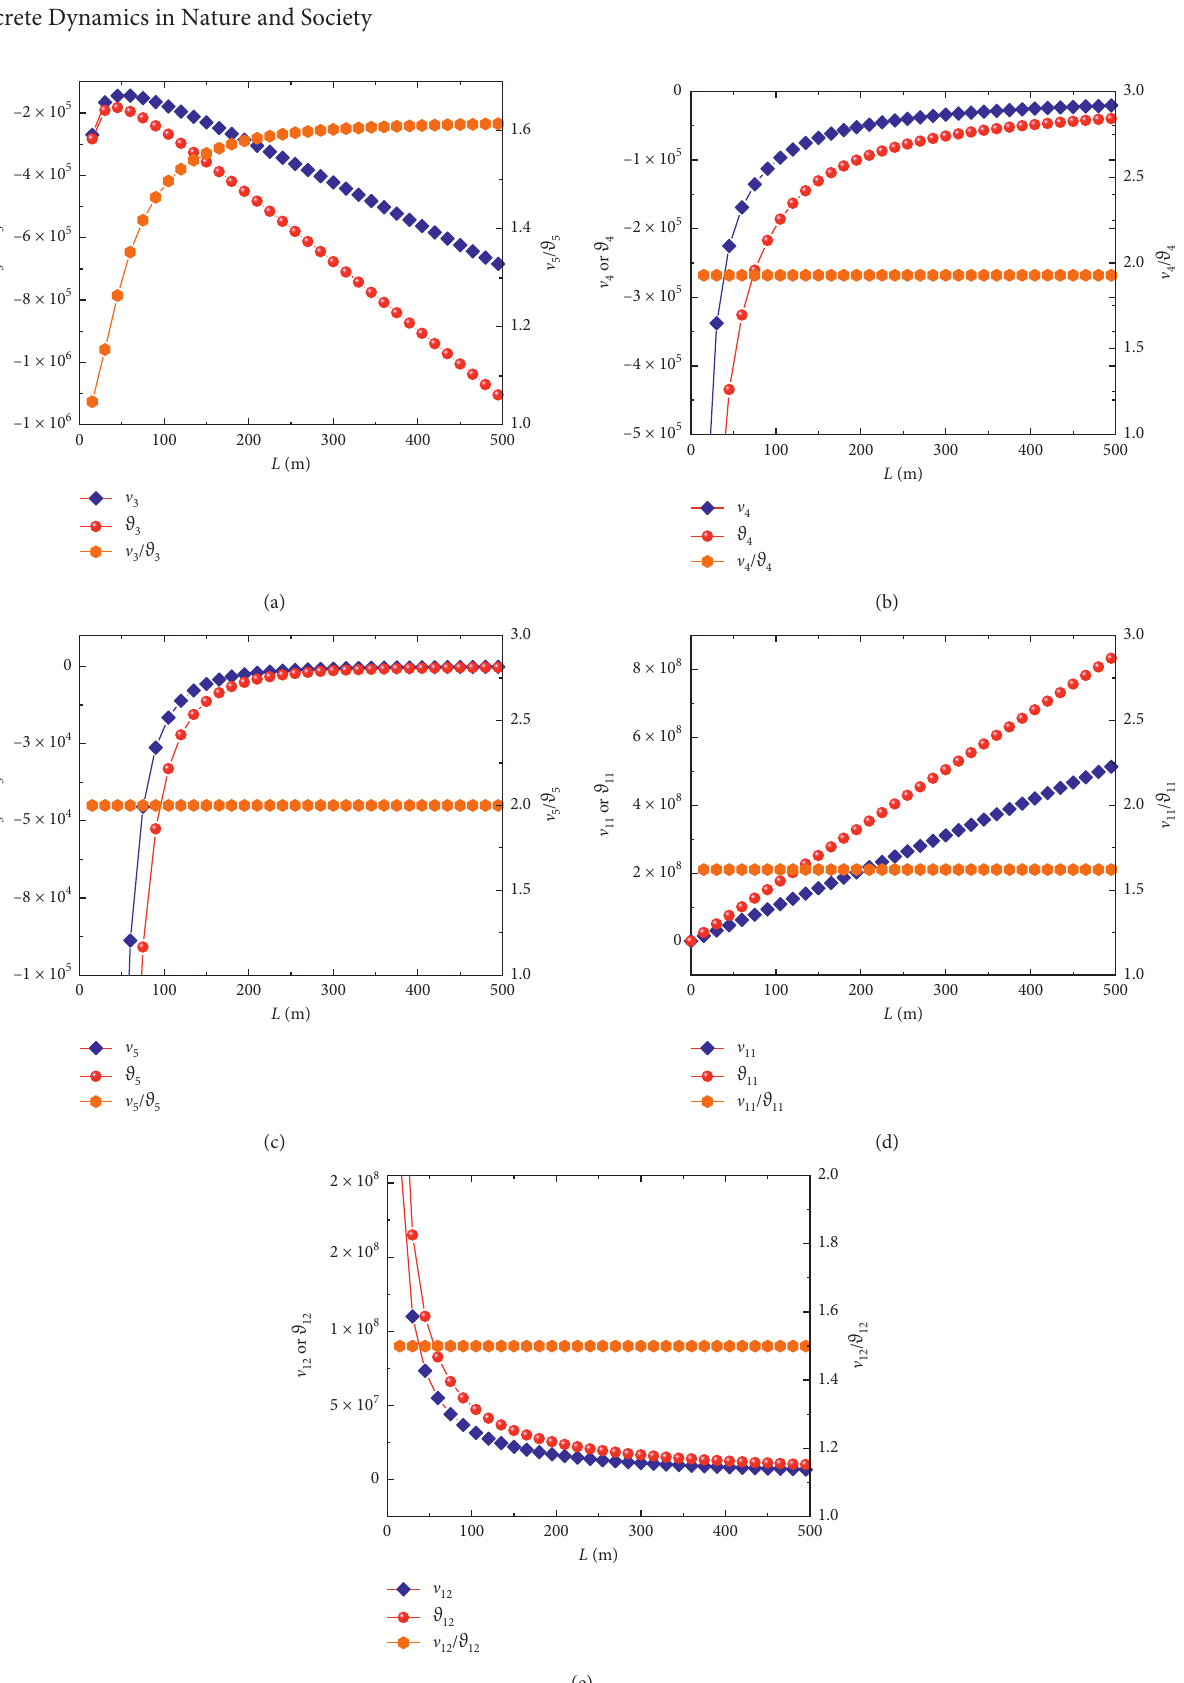
and ϑ ; (b) coefficients of ] 3 3